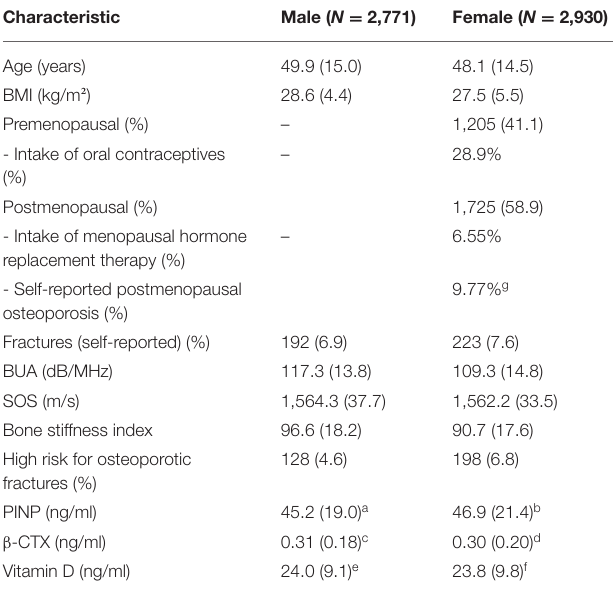
TABLE 1 | Baseline characteristics of the study